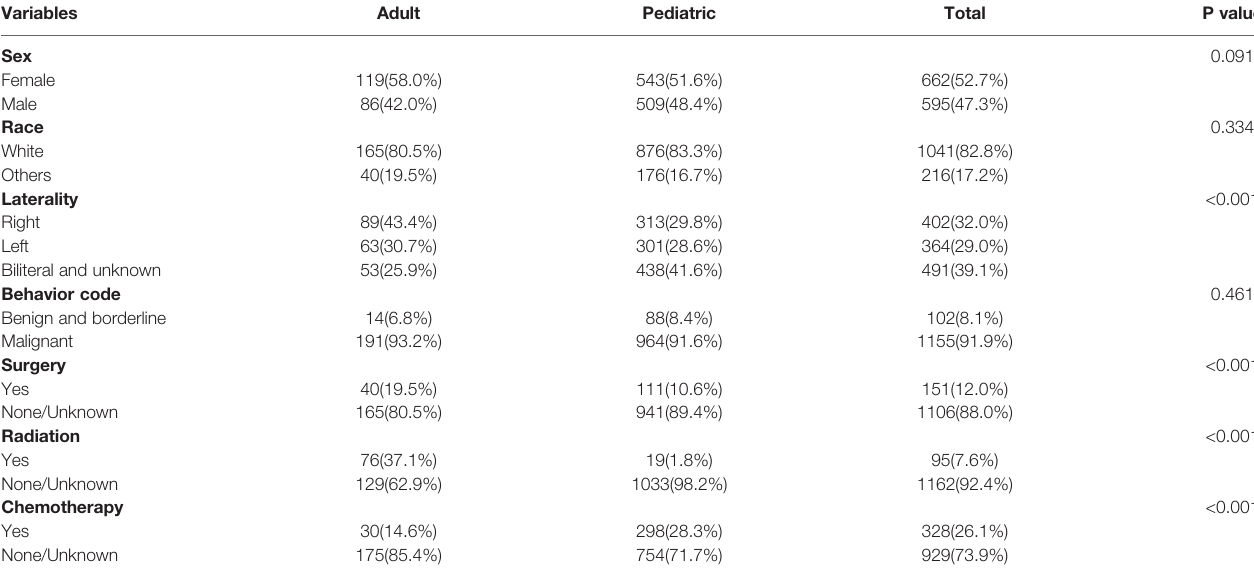
TABLE 1 | Demographic and clinical characteristics of patients with optic pathway